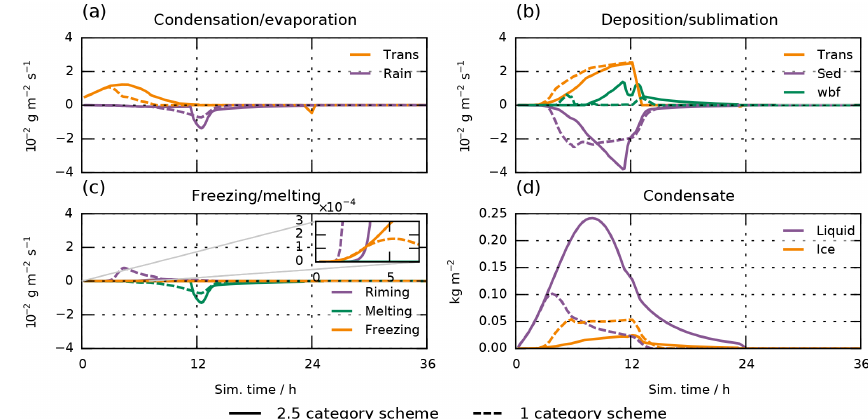
Figure 10. Time series for the vertically integrated phase change process rates for the simulations described in the text. The solid lines show results from the 2.5-category scheme with diagnostic snow and falling ice and the dashed lines show the results from the single- category scheme with prognostic ice sedimentation. Panels (a) – (c) show the rates of phase changes; (d) shows the vertically integrated condensate. Condensation and deposition rates are divided into changes due to transport (forcing term), evaporation of rain and sublimation of sedimenting ice. Ice growth at the expense of liquid is denoted by wbf.